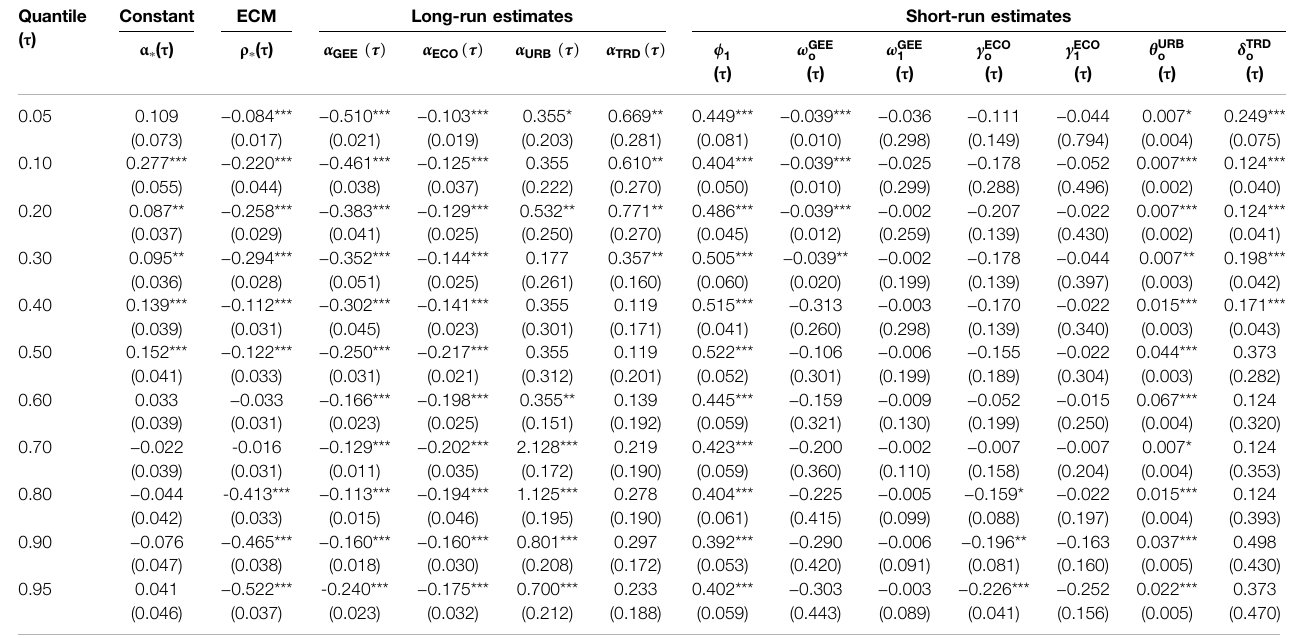
TABLE 4 | Long-short run estimates of quantile ARDL